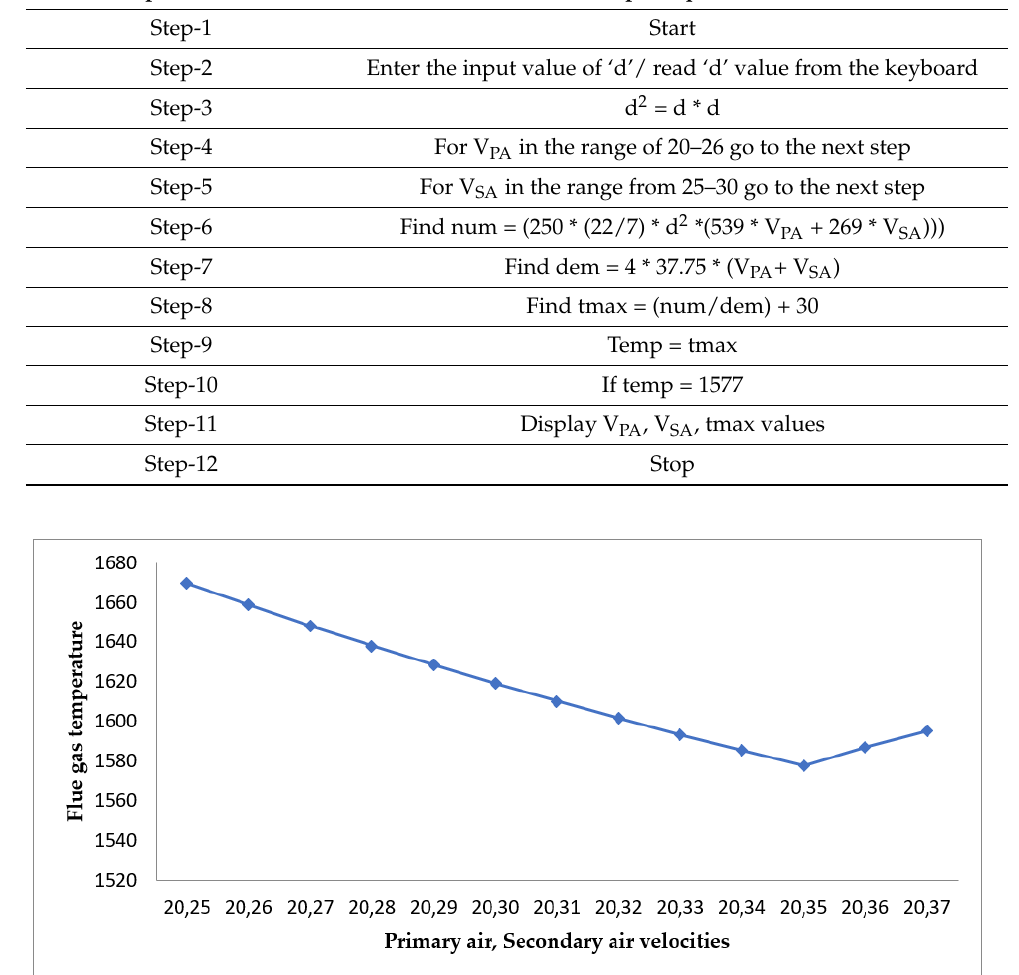
Table 11. Python programming algorithm.